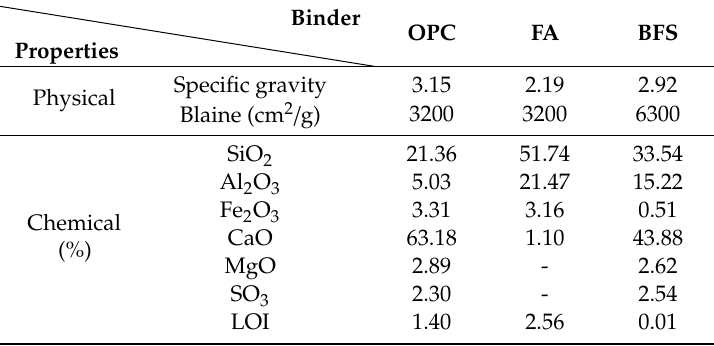
Table 1. Physical properties and chemical compositions of the binders.